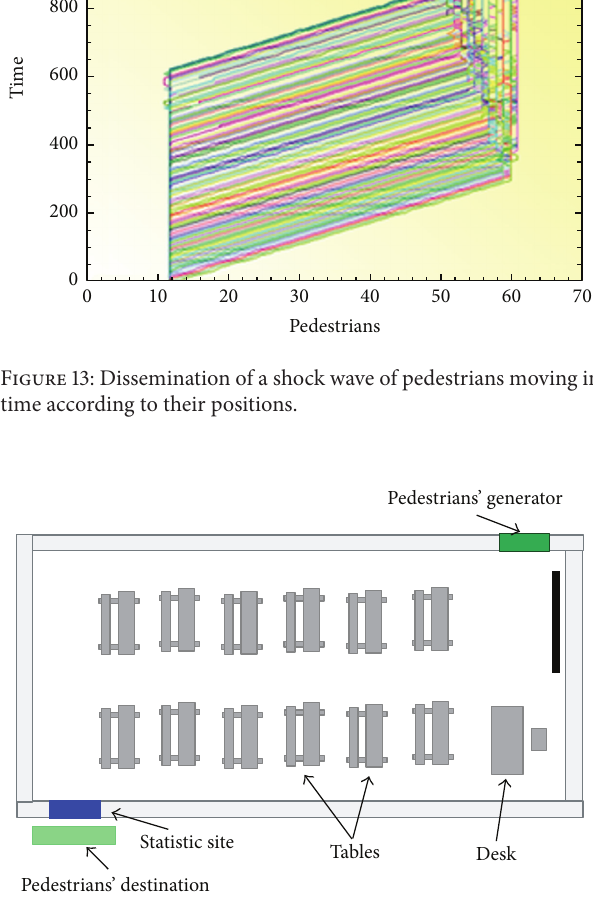
Figure 14: Simulation scenario as a classroom.